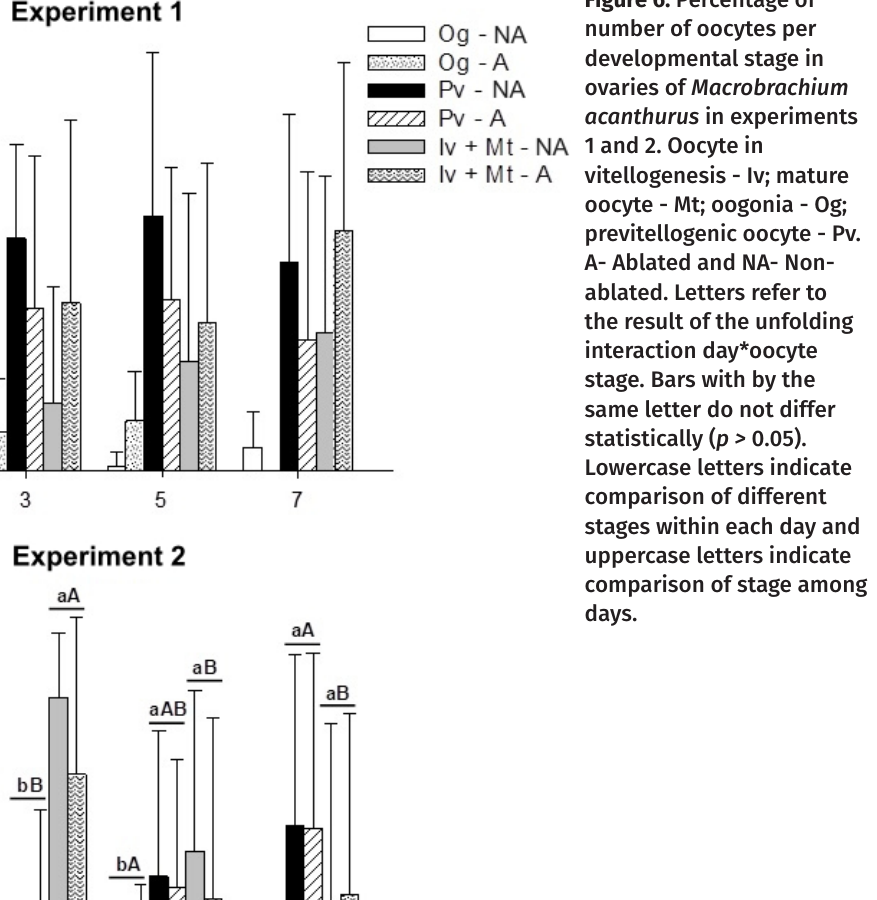
Figure 6. Percentage of number of oocytes per developmental stage in ovaries of Macrobrachium acanthurus in experiments 1 and 2. Oocyte in vitellogenesis - Iv; mature oocyte - Mt; oogonia - Og; previtellogenic oocyte -